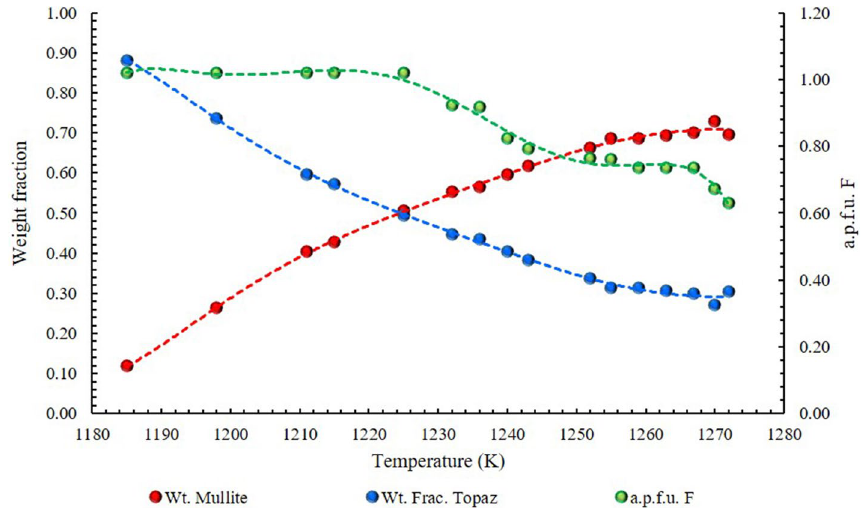
Figure 9. Fluorine behaviour in topaz-mullite transition zone (1170–1273 K; see also Fig. 5b). F atoms in topaz (atomic formula unit, a.p.f.u.: green pattern); weight fractions (wt. fract.) of topaz and mullite in blue and red patterns, respectively. At 1181 K topaz decomposition starts together with the appearance of a mullite phase (up to 0.10 wt. fract). F remains strongly partitioned in topaz up to 1225 K, but reduces the weight fraction of this phase in the system by 50%. At higher temperatures, in a very narrow increasing interval, fluorine is largely released by the topaz structure, reaching 0.80 a.p.f.u. at 1252 K and concurrently mullite becomes the dominant phase (~ 70%). This F content is stabilized in the remnant topaz (~ 30%) up to 1270